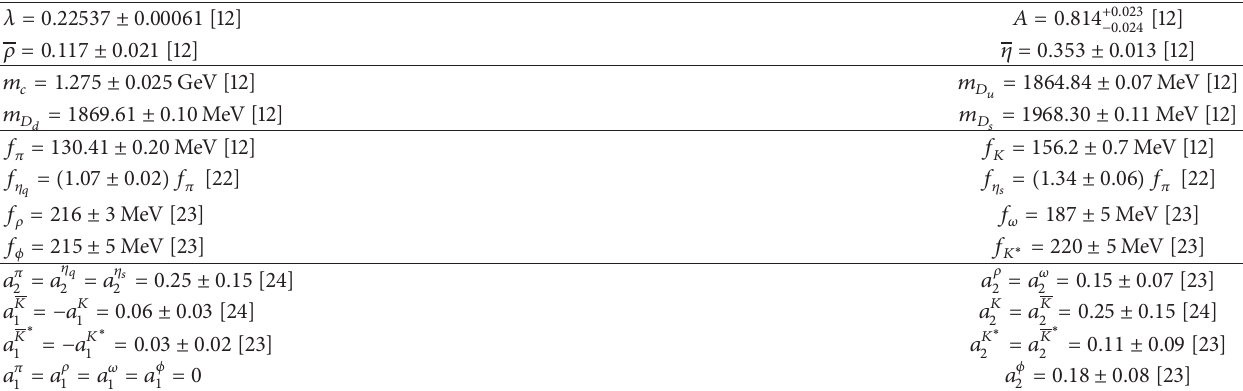
Table 4: Numerical values of input parameters.